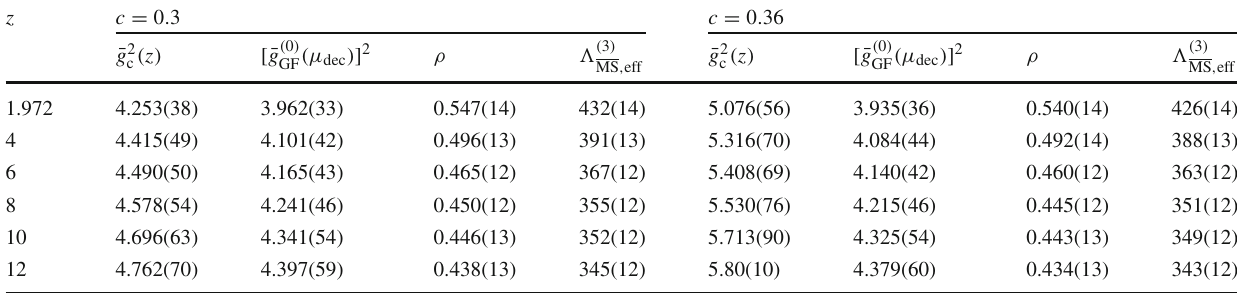
( 0 ) (μ ) ] 2 is used dec GF